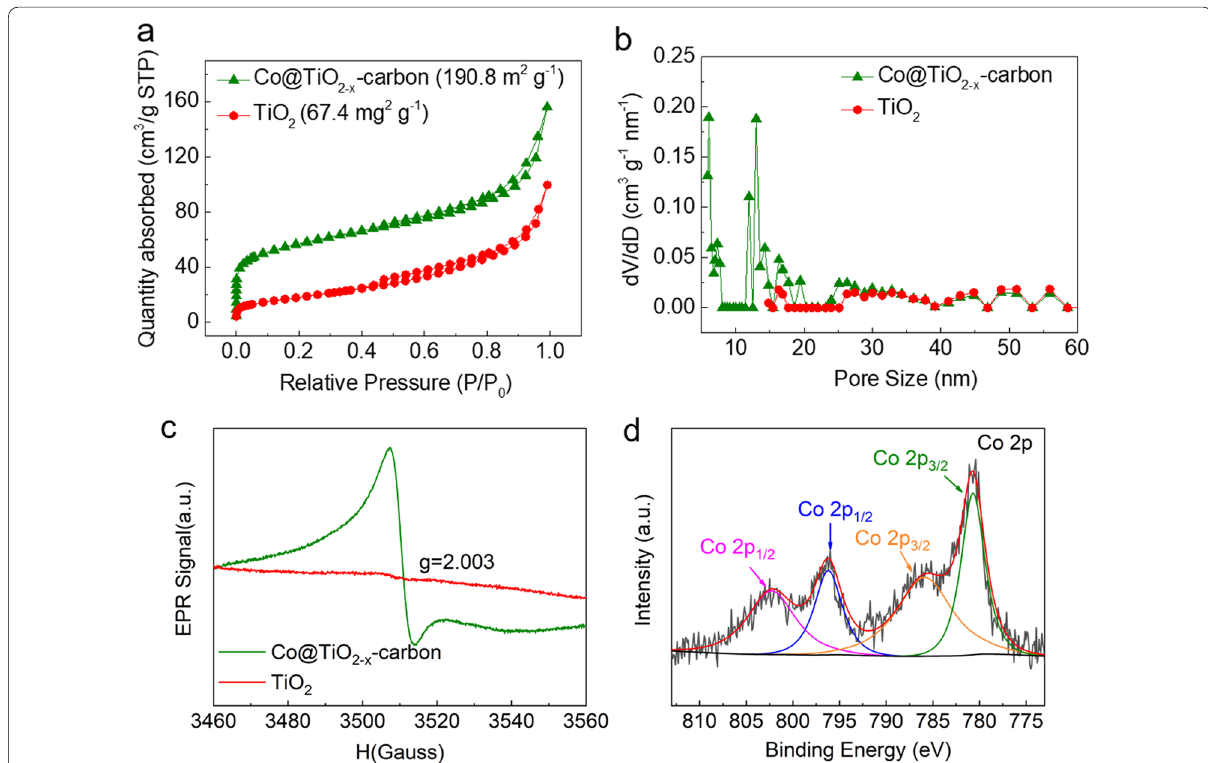
Fig. 5 a N 2 adsorption-desorption isotherms; b pore size distributions; c EPR spectra of Co@TiO 2 TiO 2 − x